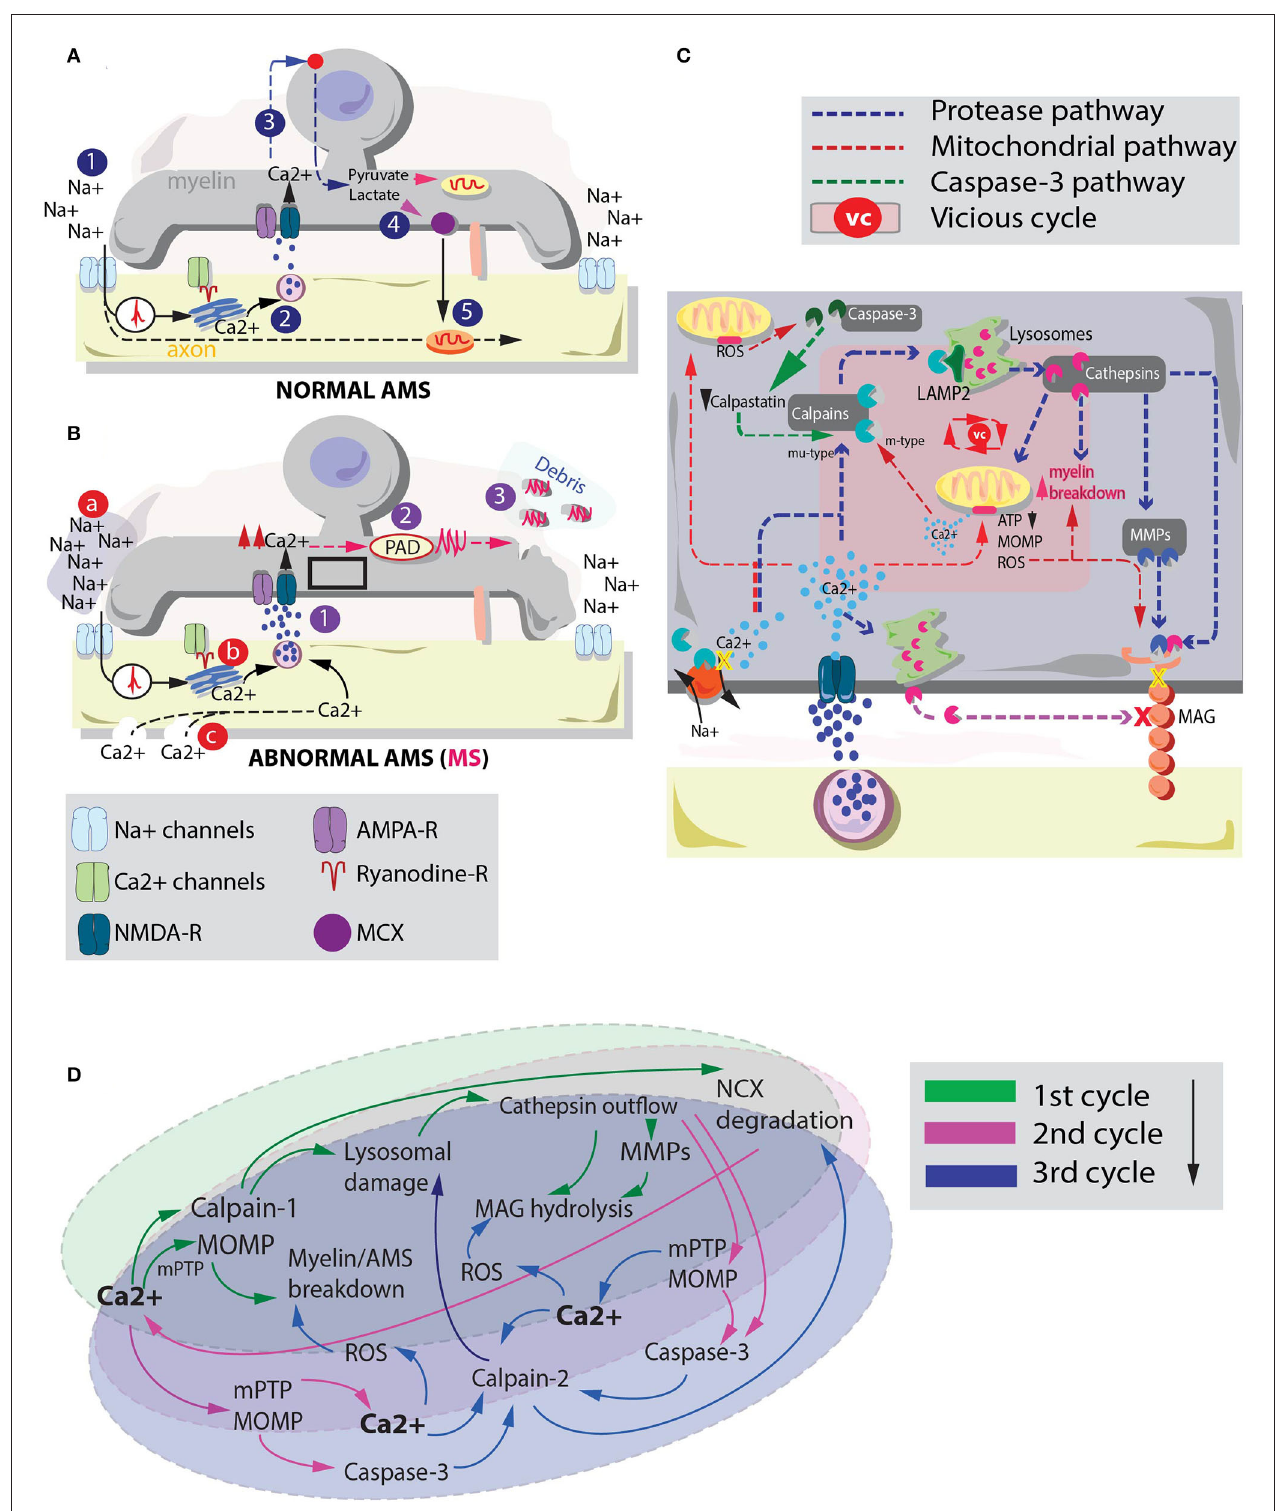
FIGURE 1 | Interplay between cysteine protease activation and mitochondrial deteriorating processes in MS myelin degeneration. (A) graphical depiction of the AMS in physiological conditions (Micu et al., 2018). The action potential (1) is sensed by Ca 2 + channels which via a ryanodine receptor-dependent mechanism mobilize the